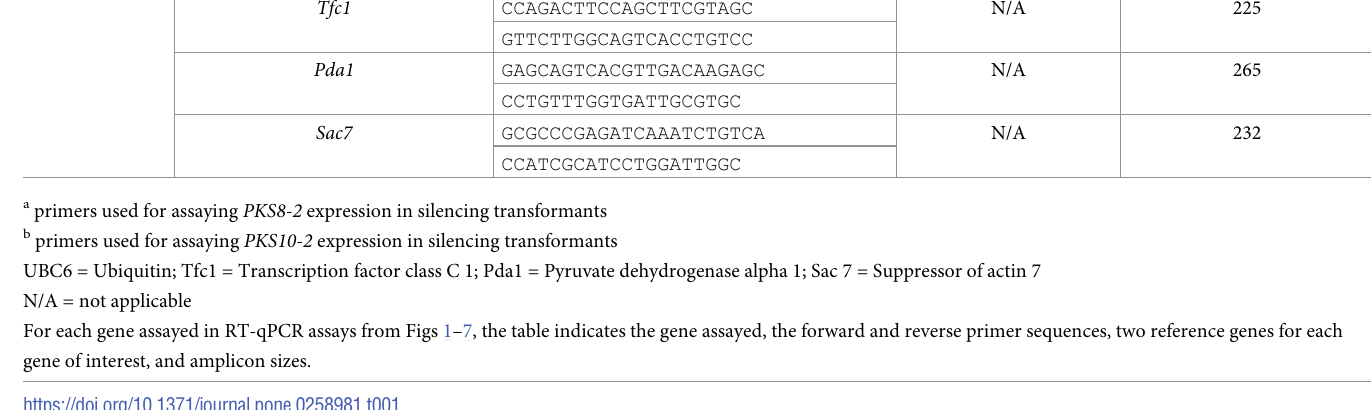
For each gene assayed in RT-qPCR assays from Figs 1–7, the table indicates the gene assayed, the forward and reverse primer sequences, two reference genes for each gene of interest, and amplicon